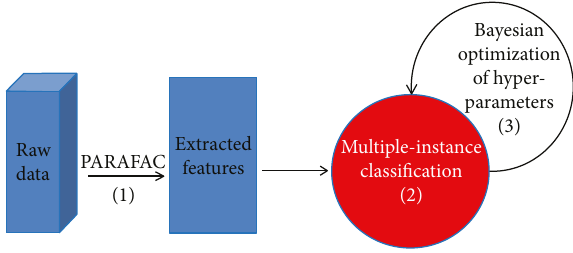
Figure 1: Schematic diagram of the proposed